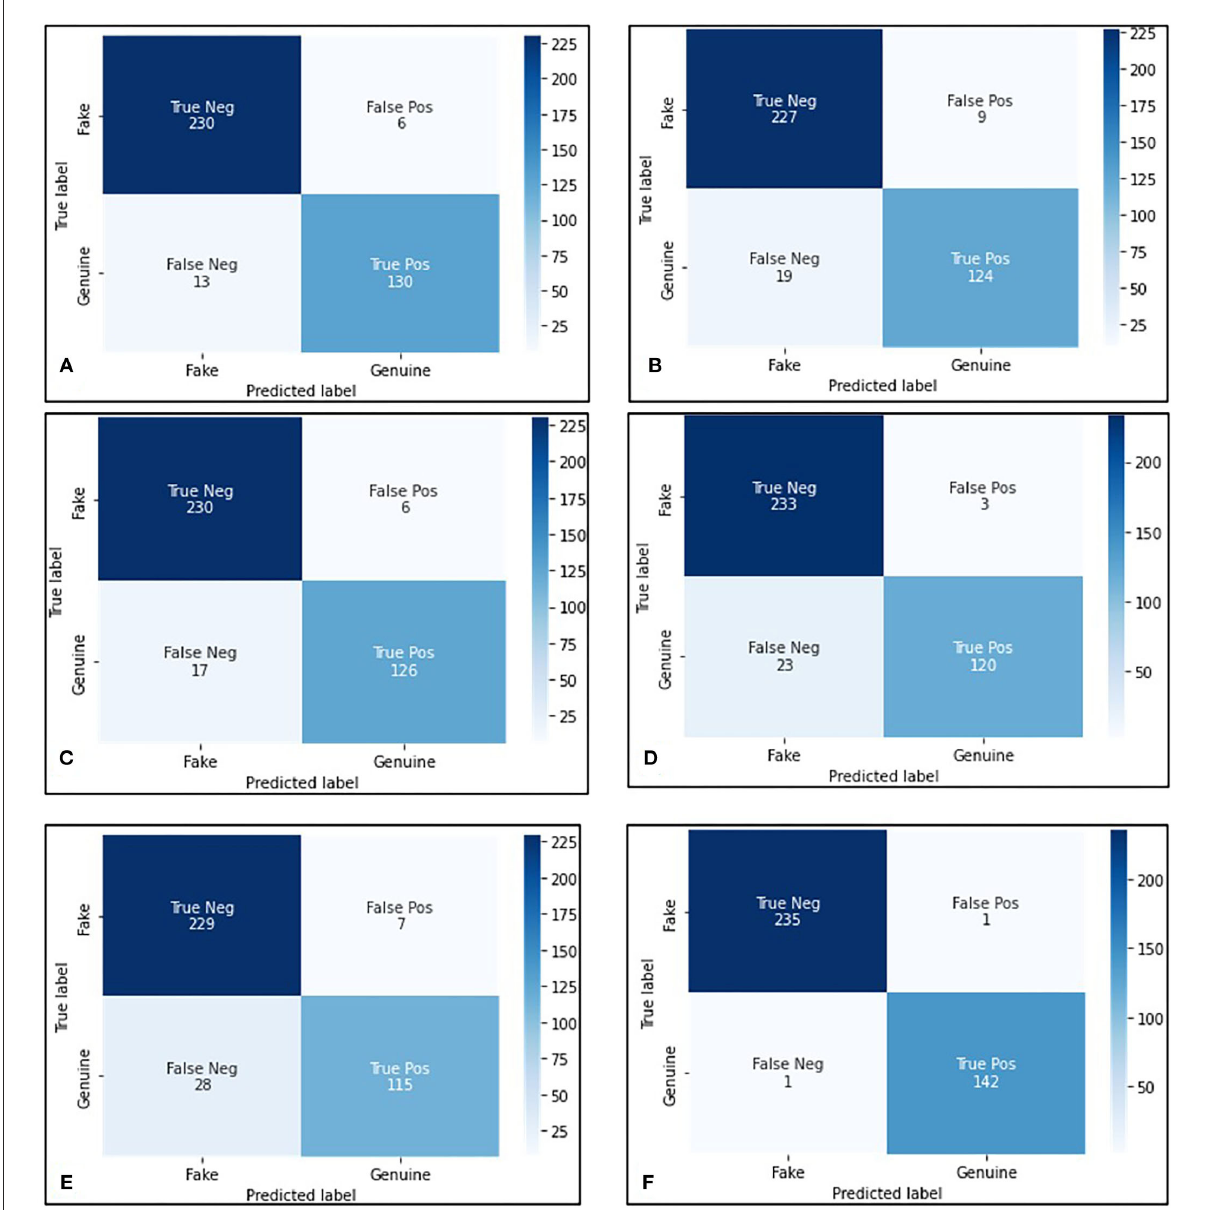
FIGURE4 Quantitative analysis based on the test dataset. Confusion Matrix for: (A) random forestand SVM, (B) ResNet18 with random weight initialization, (C) ResNet18 pre-trained—network is not in freeze state, (D) DenseNet121 with random weight initialization, (E) DenseNet121 pre-trained—network is not in freeze state, and (F) ReNet18 and DenseNet121 pre-trained network, with all the layers in freeze state, but the last two